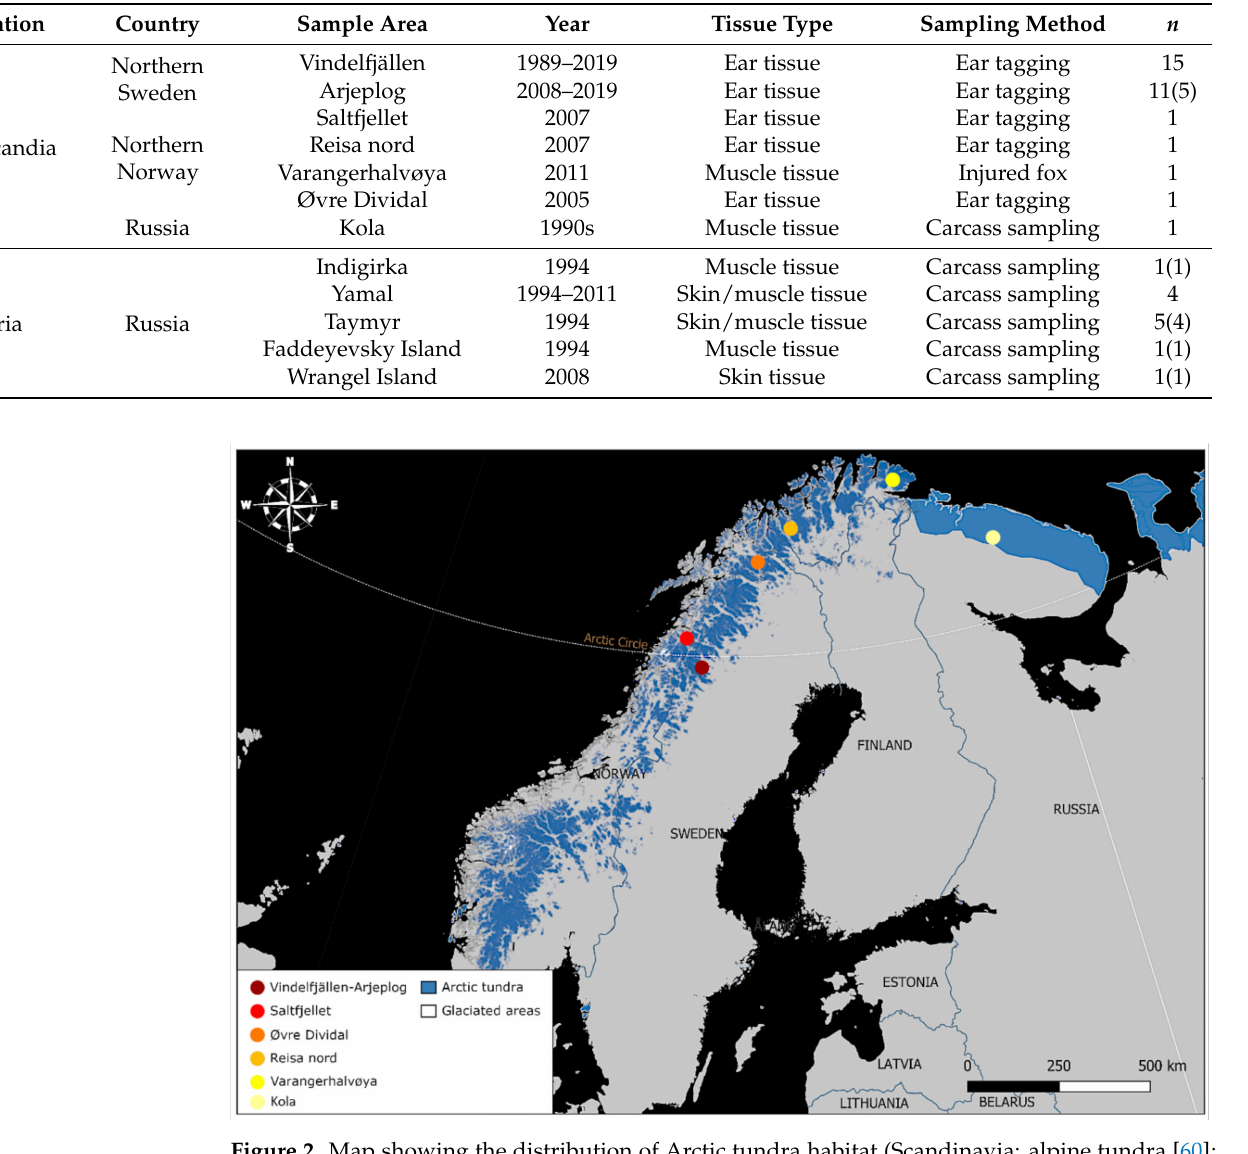
Table 1. Summary of country, area, year, tissue type, sampling method and number of individuals used for whole genome analyses, with new samples sequenced for this study in parentheses.